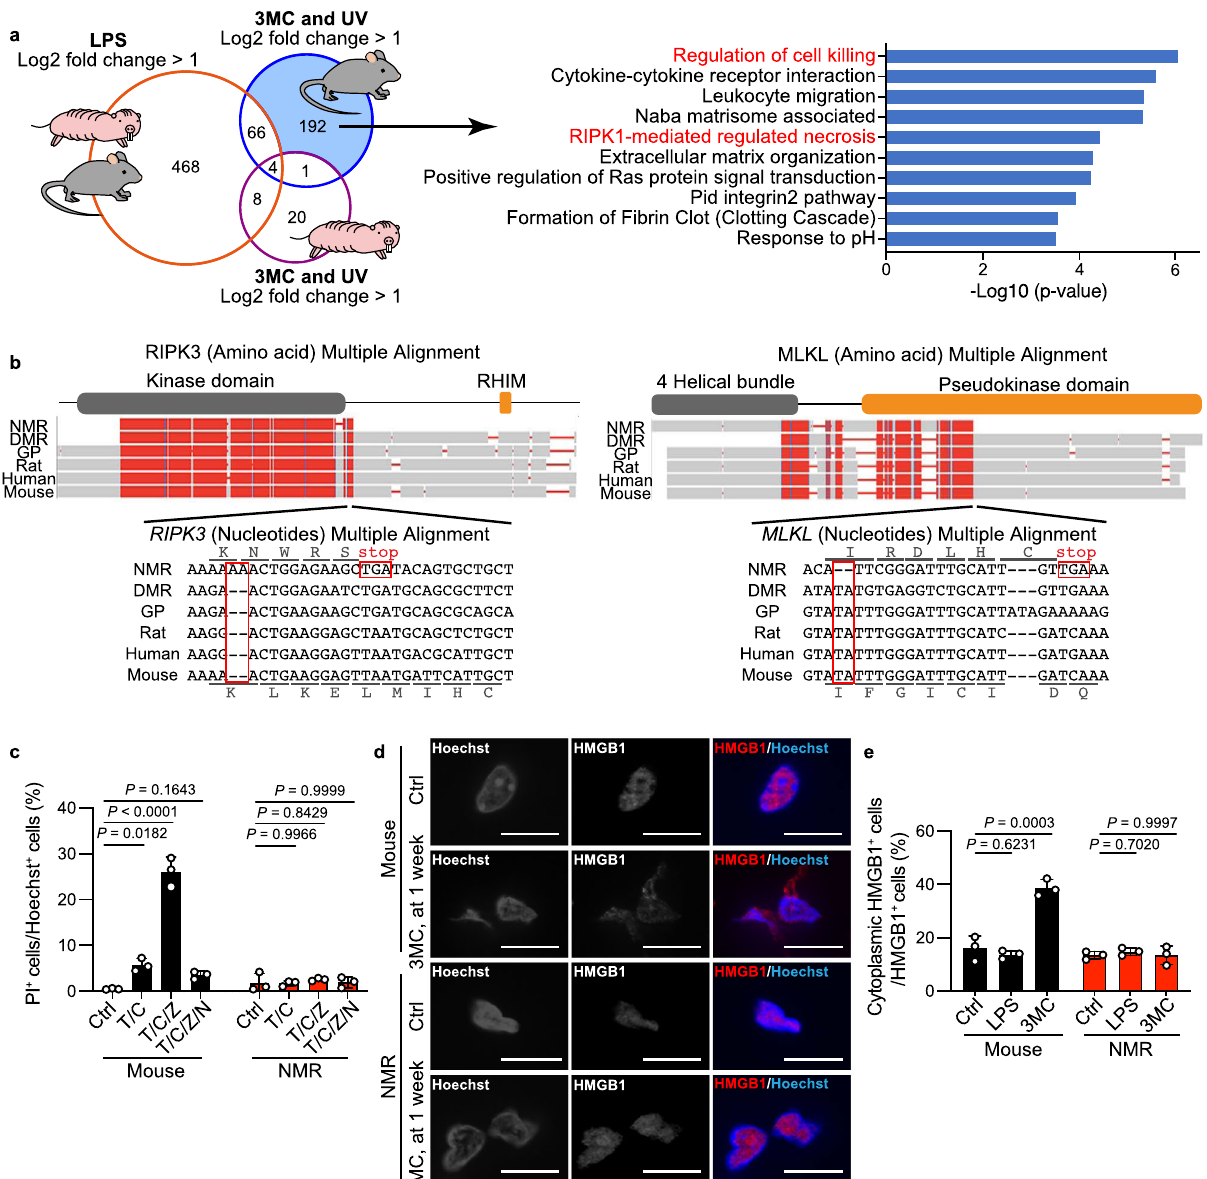
Fig. 4 Loss of necroptosis regulators in naked mole-rats (NMRs). a Venn diagram showing the number of genes upregulated in both mouse and NMR skin upon lipopolysaccharide (LPS) treatment; genes upregulated speci fi cally in mouse or NMR skin upon exposure to 3-methylcholanthrene (3MC, 1 week) and UV; and enriched pathways of 3MC-UV Mouse-DEGs. b Multiple alignments of receptor-interacting kinase 3 ( RIPK3 ) and mixed lineage kinase domain-like ( MLKL ) sequences from the NMR, Damaraland mole-rat (DMR), guinea pig (GP), rat, human, and mouse. Frame-shift mutations and premature stop codons in the NMR sequence are boxed. Reading frames for the NMR and mouse sequences are indicated. The functional domains are shown above the alignments. c Cell death analysis in fi broblasts treated with a combination of TNF- α (T), cycloheximide (C), z-VAD-fmk (Z), or Nec-1 (N). Data are presented as the mean ± SD of n = 3 independent experiments. d Immuno fl uorescence staining of high mobility group box-1 protein (HMGB1) in skin at 1 week after 3MC-injection. Scale bar: 10 μ m. e Quanti fi cation of cytoplasmic HMGB1 in skin after each treatment. Data are presented as the mean ± SD of n = 3 animals for each species. One-way ANOVA with Tukey ’ s multiple comparison test for ( c ) and Dunnett ’ s multiple comparisons test versus untreated control (Ctrl) for ( e